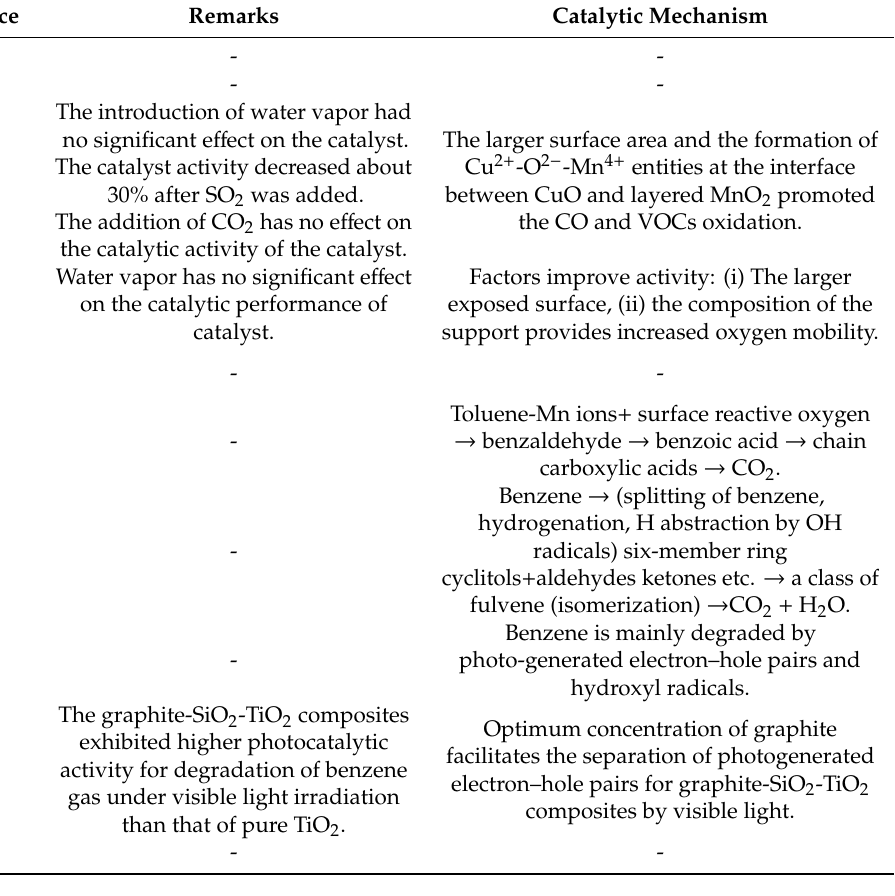
Table 4. Reported catalysts for VOCs